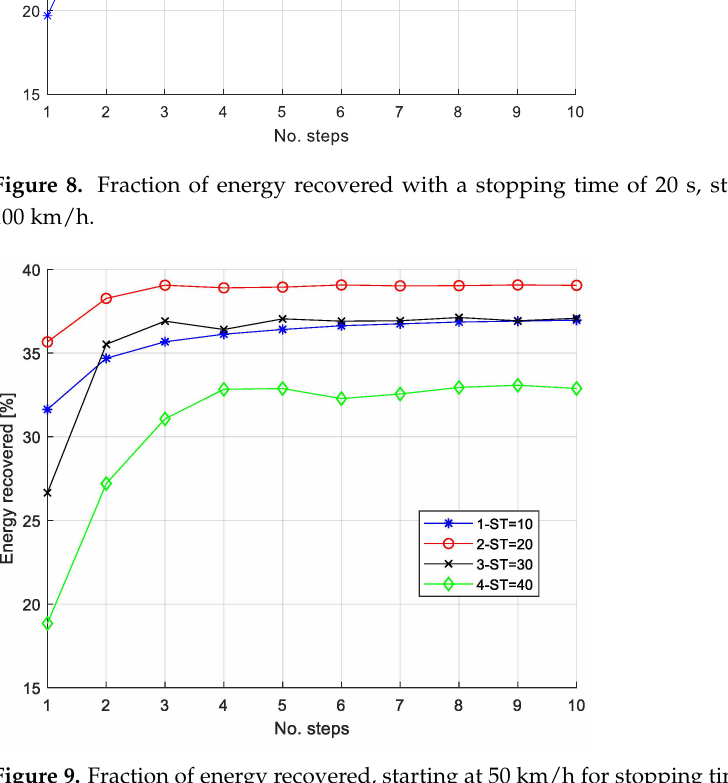
Figure 9. Fraction of energy recovered, starting at 50 km/h for stopping times from 10 to 40 s.